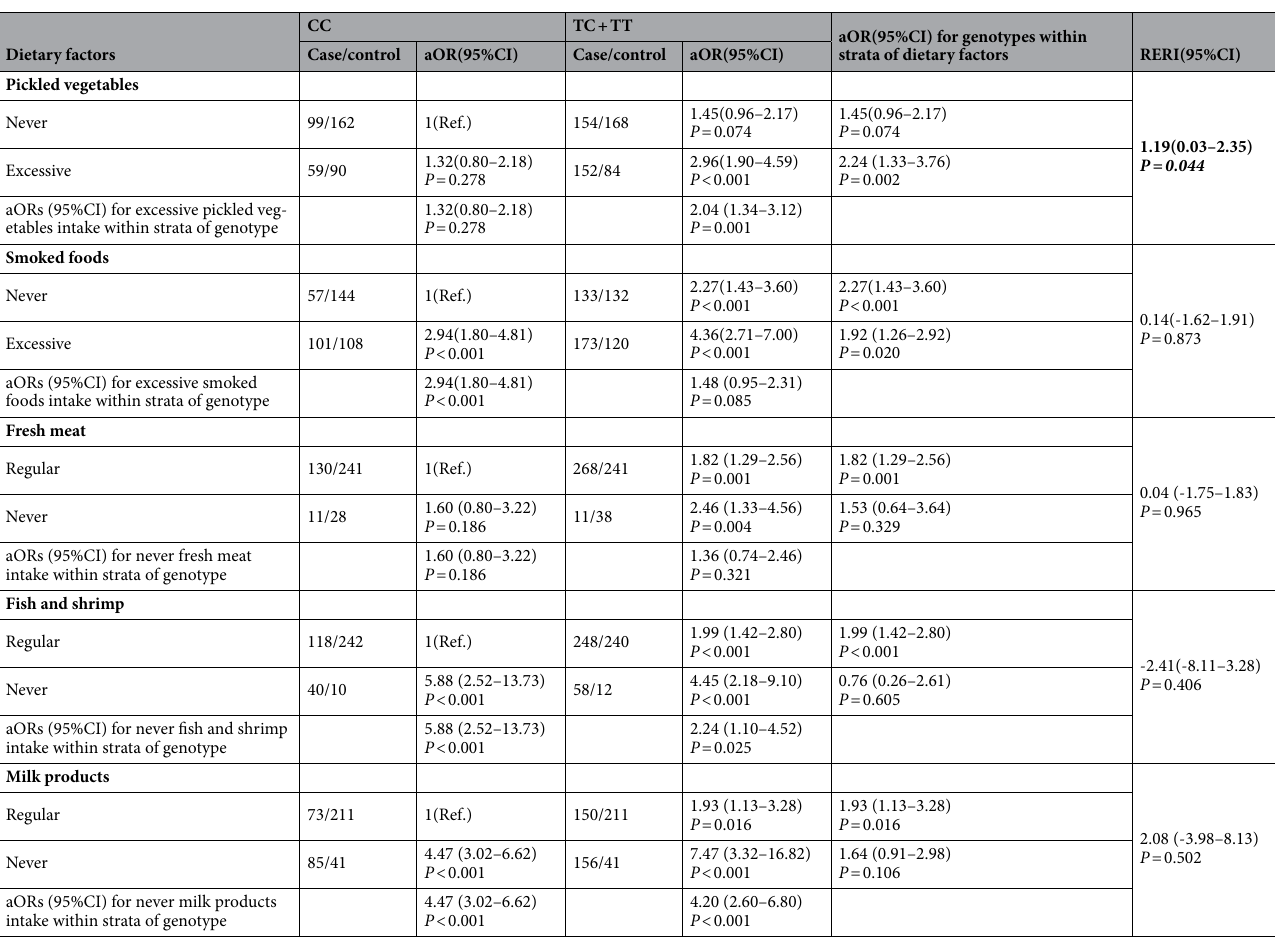
Table 3. Interaction between the dominant model of rs659366 and maternal dietary factors for the risk of CHDs. CHDs congenital heart diseases; aORs adjusted odds ratios; 95%CI 95% confidence intervals; RERI The relative excess risk due to interaction. Adjusted for baseline characteristics that were significantly different among two groups.